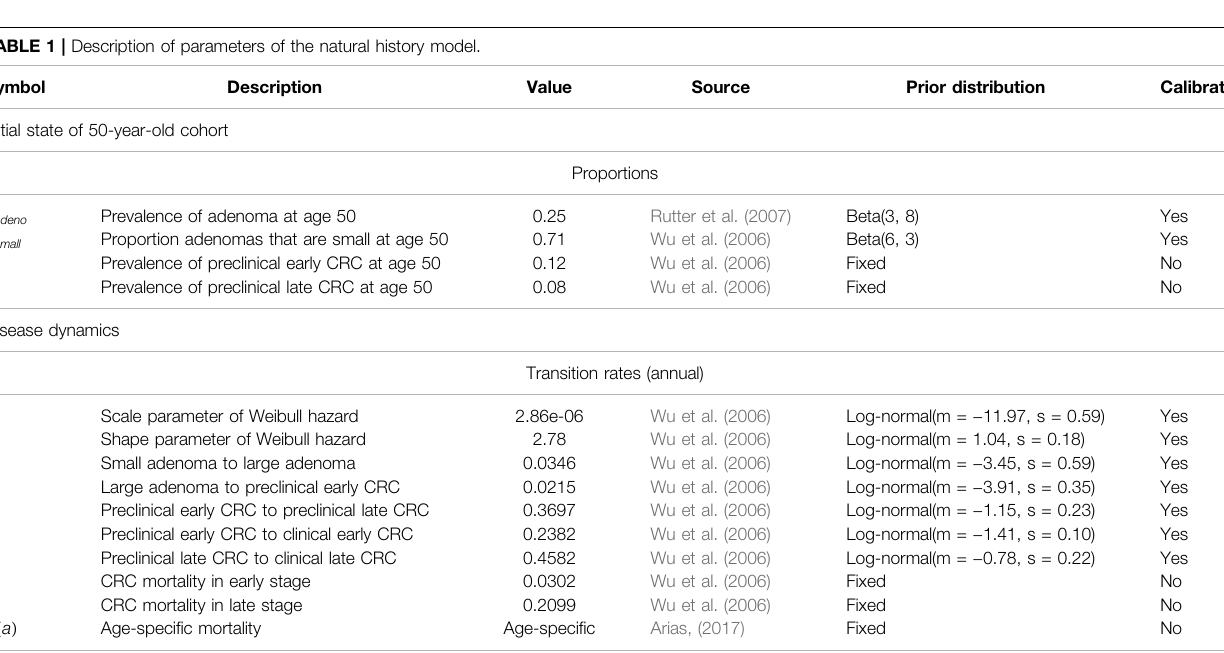
TABLE 1 | Description of parameters of the natural history model. Symbol Description Value Source Prior